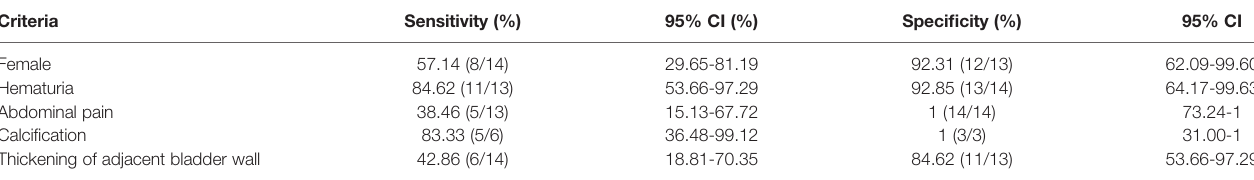
TABLE 5 | Sensitivity and speci fi city of signi fi cant